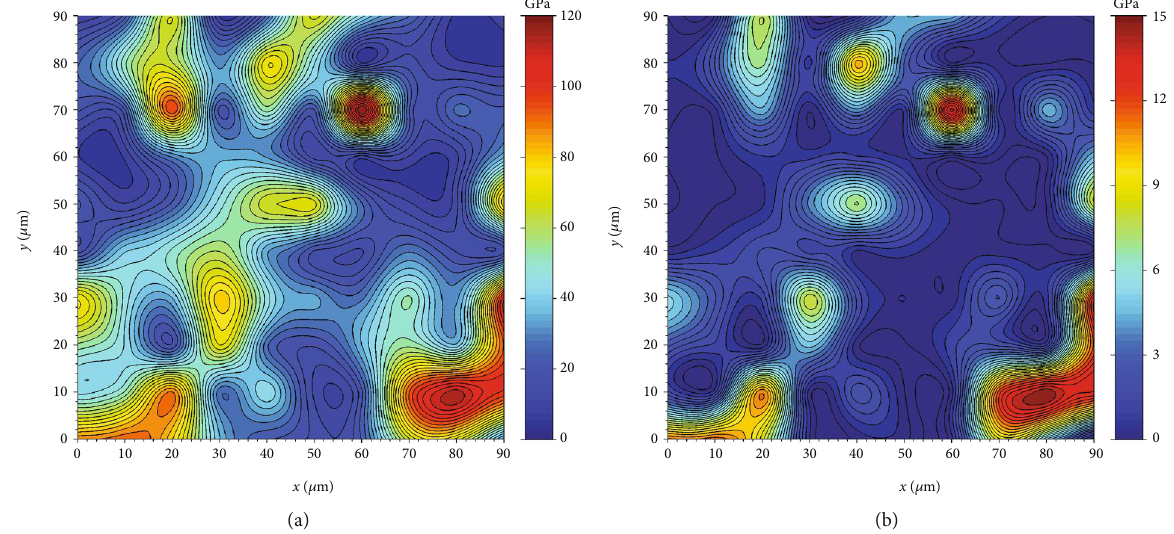
Figure 9: Distribution of (a) indentation modulus and (b) hardness in the tested region of specimen NM-1.